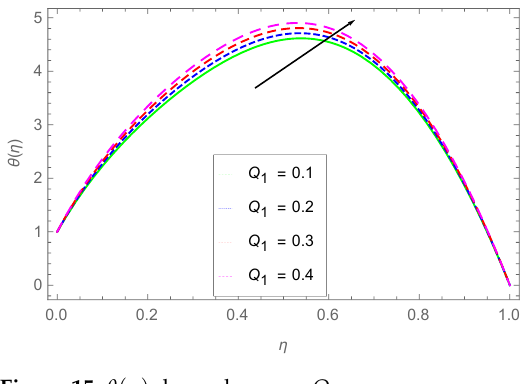
Figure 15. θ ( η ) dependence on Q .